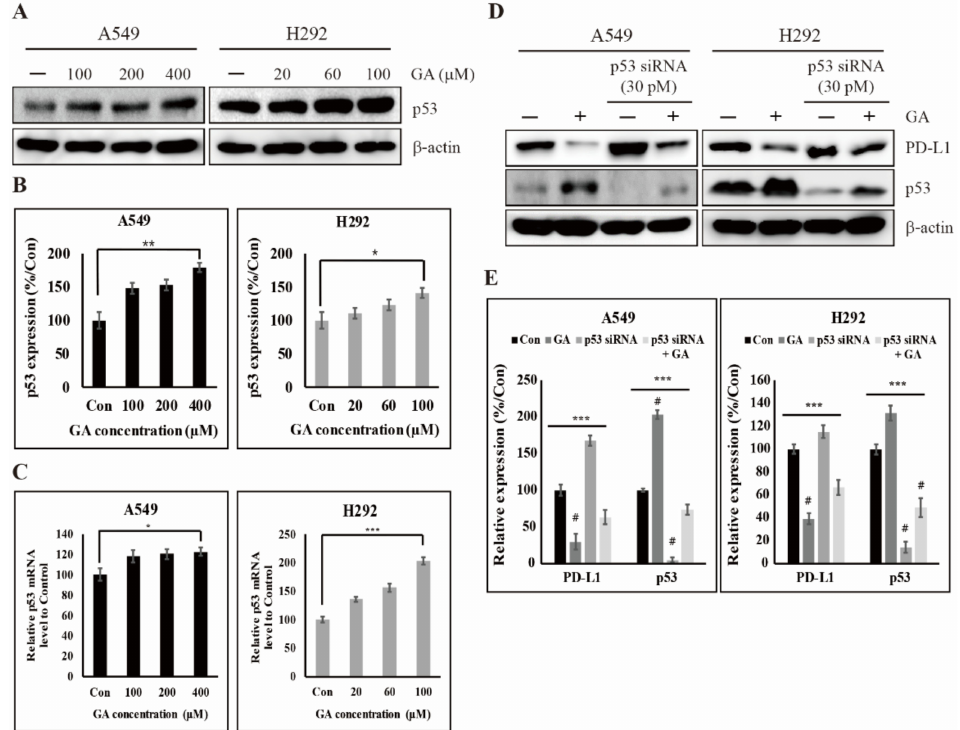
Figure 4. GA increased p53 expression. ( A ) The expression levels of p53 protein in A549 and H292 cells were detected after GA treatment in concentrations indicated for 48 hours. ( B ) The relative expression levels of p53 protein were determined by densitometry and normalized to β -actin. Data are representative of three independent experiments. * p < 0.05 and ** p < 0.01 ( t- test). ( C ) The expression levels of p53 mRNA in A549 and H292 cells were detected by real time qPCR after GA treatment in concentrations indicated for 48 hours. The relative expression levels of p53 mRNA were determined and normalized to GAPDH mRNA. Data are representative of three independent experiments. * p < 0.05 and *** p < 0.001 ( t- test). ( D ) The expression levels of p53 and PD-L1 protein in A549 and H292 cells, treated with GA (A549: 400 µ M; H292: 100 µ M) or 30 pM p53 siRNA, were detected by western blotting at 48 hours. ( E ) The relative expression levels of p53 and PD-L1 protein were determined using densitometry and normalized to β -actin. Data are representative of three independent experiments. *** p < 0.001 (ANOVA); # p < 0.001 vs.